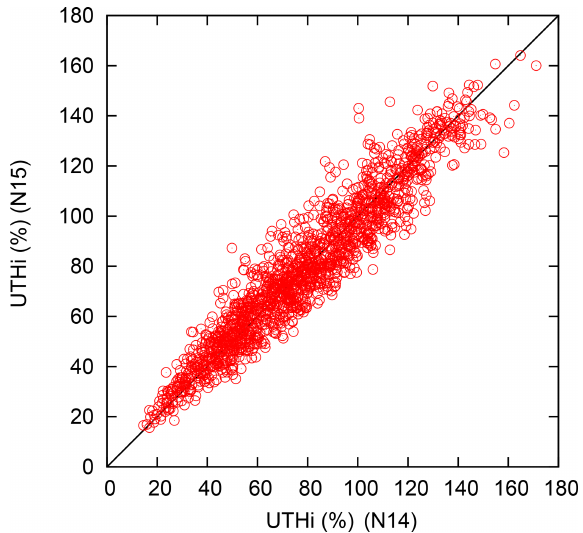
Figure 7. UTHi values from channel 12 brightness temperatures computed with a radiative transfer code using the NOAA-14 and NOAA-15 spectral response functions (Gierens et al., 2018). The UTHi values have been computed with the fit function given in the text using the coefficients from Table 1 for the two central wave- lengths 6 . 7 (NOAA-14) and 6 . 5µm (NOAA-15). The black line is simply the diagonal, and all points would ideally lie above it. Contrary to earlier inter-calibration attempts, the problem of having much more supersaturation cases in NOAA-15 than in NOAA-14 data is no longer present.